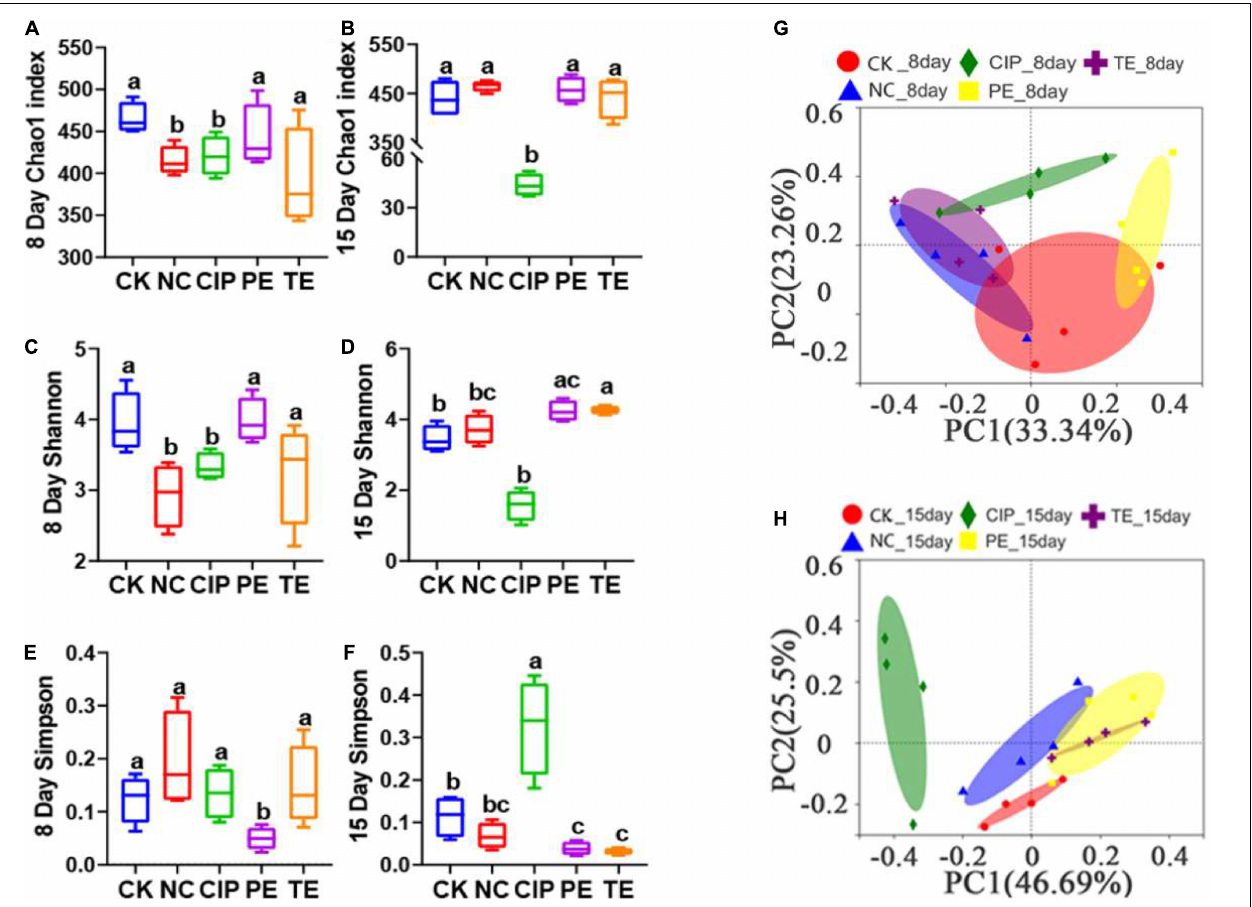
FIGURE 9 | Gut microbiota diversity. (A,B) Alpha diversity boxplot of the Chao1 index on day 8 and 15. (C,D) Alpha diversity boxplot of the Shannon index on day 8 and 15. (E,F) Alpha diversity boxplot of Simpson index on day 8 and 15. (G,H) PCA using unweight-unifrac of beta diversity on day 8 and 15. The sane small-letter means no different P > 0.05; Different lowercase letters have significant differences P <